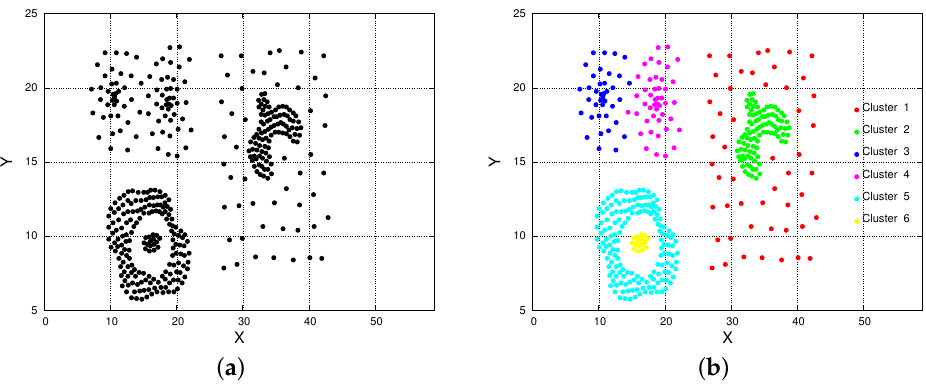
Figure 3. The Compound dataset: ( a ) data instances and ( b ) target